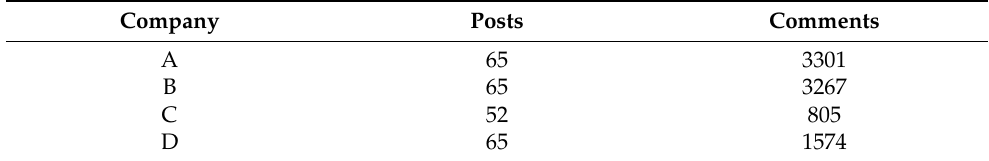
Table 1. Summary of extracted